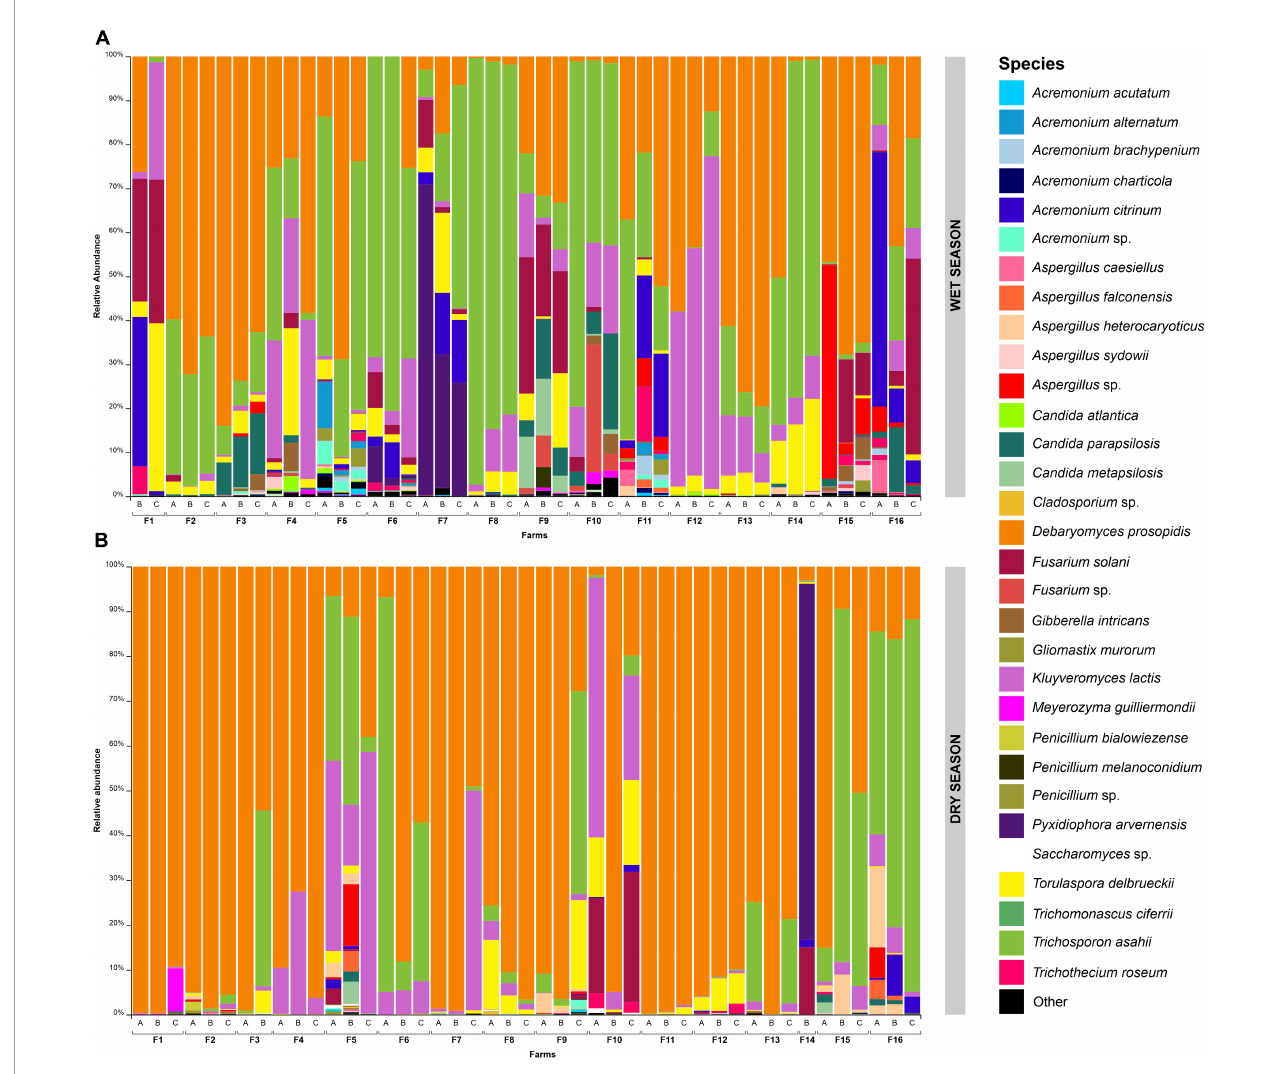
FIGURE4 Barplot showing the relative abundance of the 25 main fungi species (ITS1 and ITS2) detected in the surface of Canastra cheese samples collected in wet season (A) and dry season (B) . Capital letters A, B, and C correspond to the cheese samples collected in the farms (from F1 to F16).